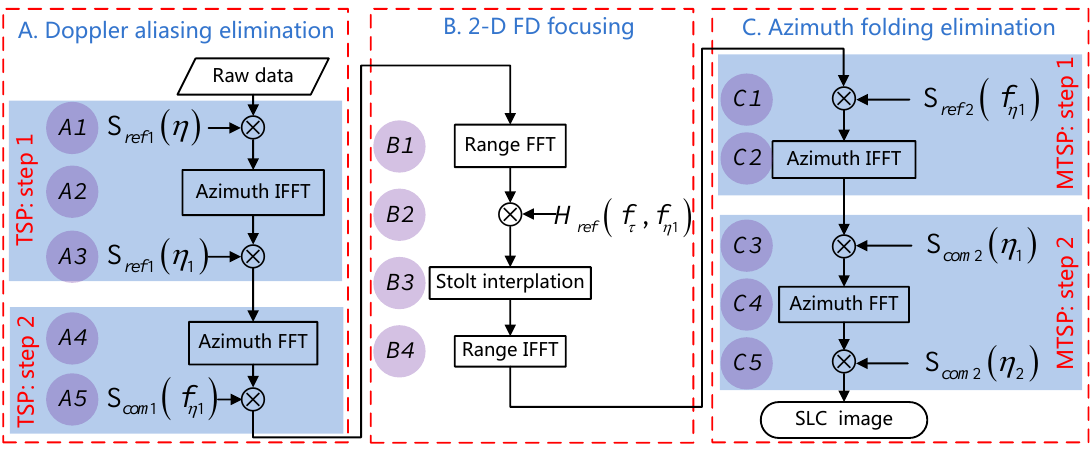
Figure 4. Flowchart of proposed imaging